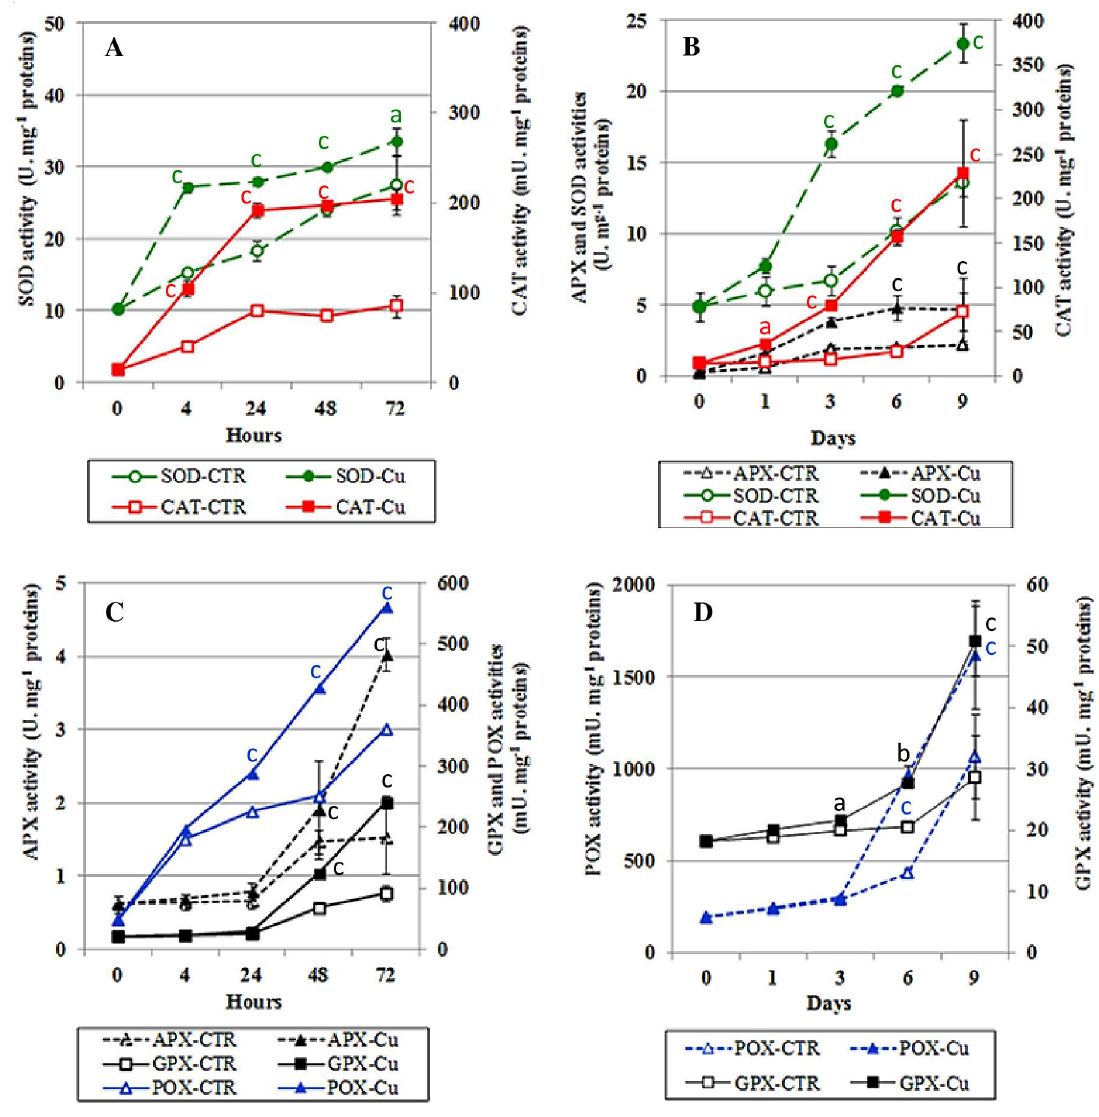
Fig 3. Enzymatic activities of SOD, CAT and peroxidases (APX, GPX and POX) in (A, C) seedlings and (B, D) cotyledons of bean seeds during germination in the presenceof distilled water (CTR) or 200 μ M Cu. Values are means ± SE (n = 5). Letters indicate significantdifferences comparedwith the respectivecontrol sample (a: p < 0.05, b: p < 0.01 and c: p < 0.001).